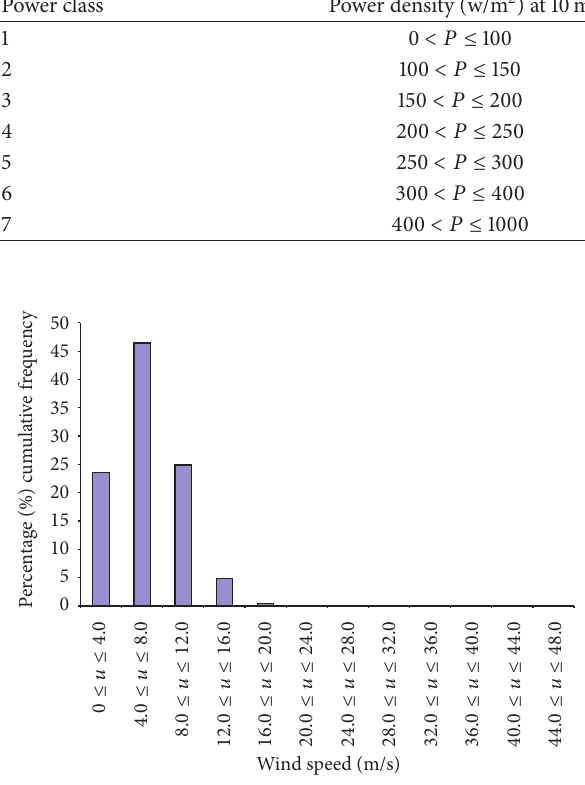
Table 4: Seasonal mean Weibull parameters, wind power density, wind speed, standard deviation, and coefficient of variation.